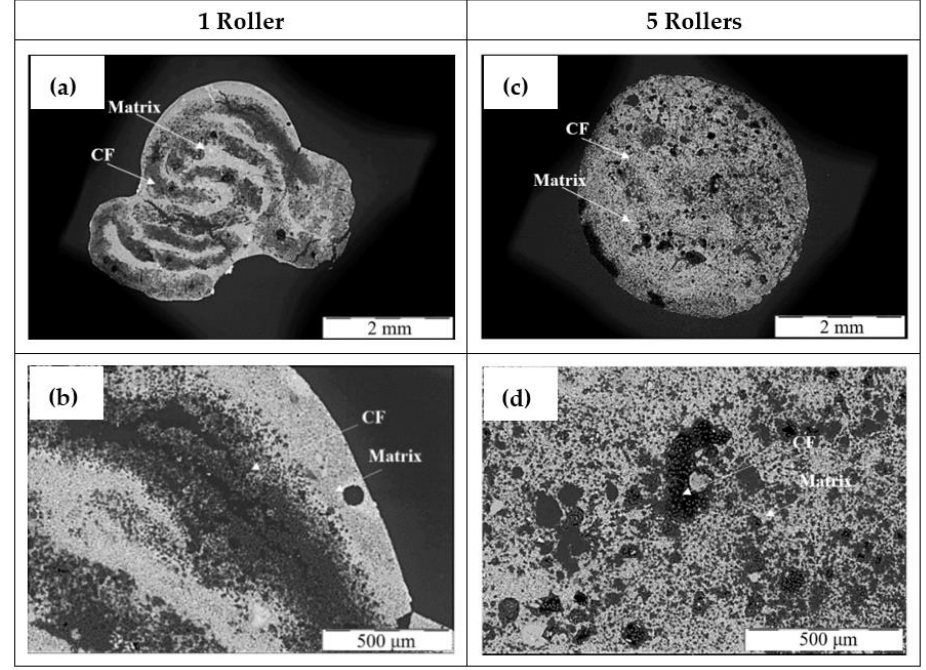
Figure 5. ESEM images of cross-sections of MCFs produced ( a , b ) with one roller and ( c , d ) five rollers at lower and higher magnification.